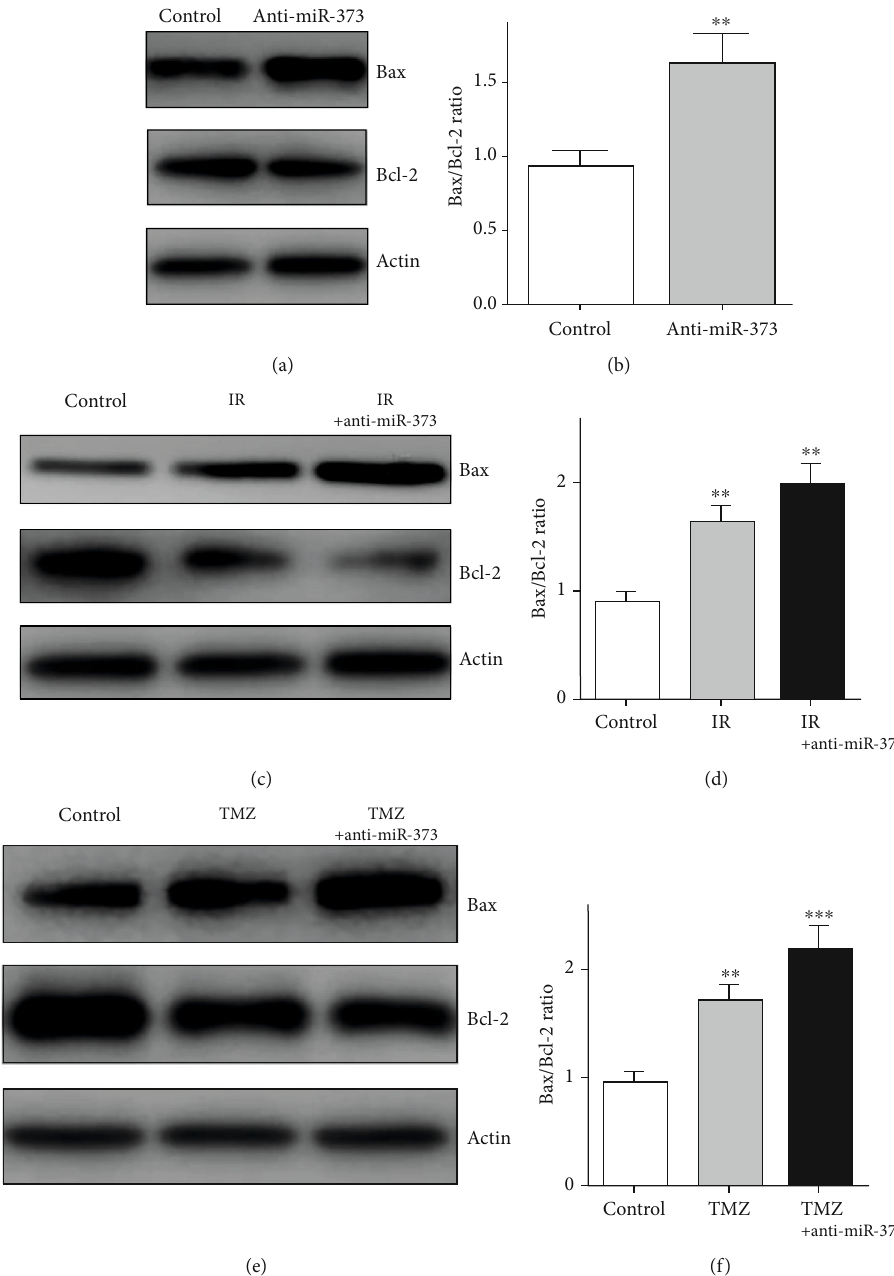
Figure 5: E ff ects of anti-miR-373 on the Bax/Bcl-2 ratio. (a, b) Anti-miR-373 could increase the Bax expression and reduce the Bcl-2 expression which resulted in the higher Bax/Bcl-2 ratio in the U-251 cells. (c, d) After ionizing radiation (IR), the Bax expression was increased combined with lower Bcl-2 expression; furthermore, the Bax/Bcl-2 ratio was also enhanced signi fi cantly after being combined with anti-miR-373 transfection. (e, f) After TMZ treatment, the Bax/Bcl-2 ratio was also increased obviously in the presence or absence of anti-miR-373 transfection, respectively (bars indicate the standard deviation of the mean; each experiment was performed in triplicate; ∗∗∗ p < 0 : 001 ; ∗∗ p < 0 : 01